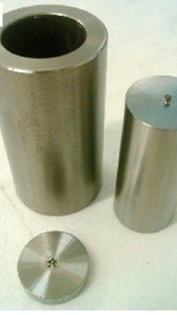
Figure 3. ( a ) Container made of a low-carbon steel and a specimen of the X210Cr12 steel; ( b ) forging in in a hydraulic press. in a hydraulic press. a hydraulic press.